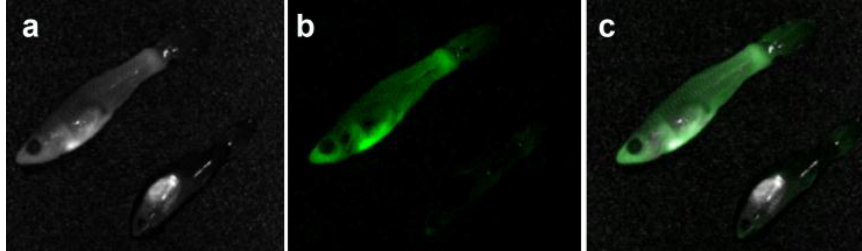
Figure 9. Ex vivo guppy fish imaging. Photograph of the starch NSs labelled guppy fish under ( a ) bright-field, ( b ) with excitation at 455 nm, and ( c ) overlay of ( a ) and ( b ) measured with CRi Meastro imaging system. Exposure time was 1500 ms. Small guppy fish in the bottom right corner was used as a control without being treated with the starch NSs.